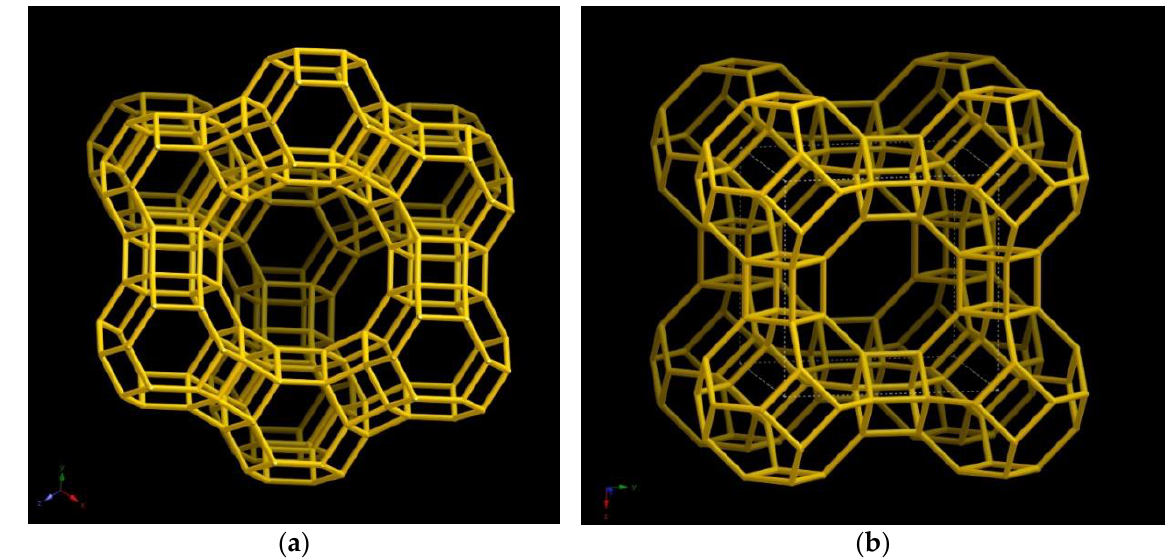
Figure 2. Structure of ( a ) Faujasite (FAU) and ( b ) Linde Type A (LTA) zeolites [23].